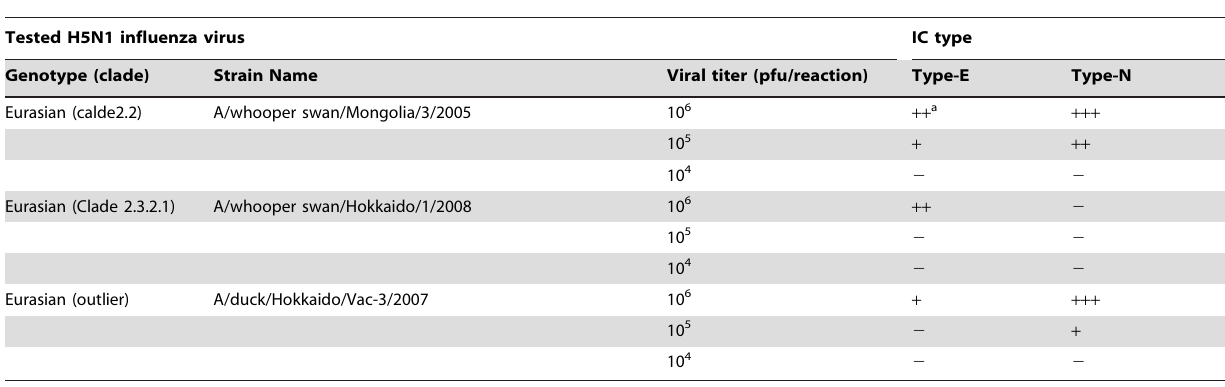
Table 3. Specificities and sensitivities of colloidal gold IC for H5 subtypes of influenza A viruses.